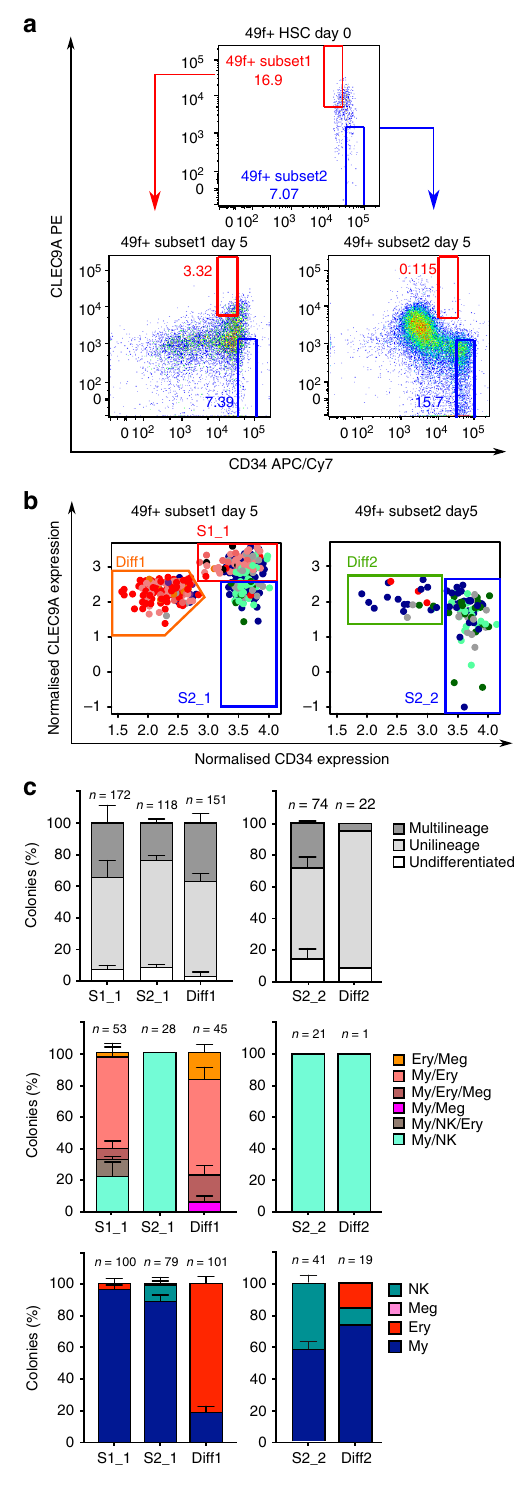
small grafts that were either My or My/Ery, while Subset2 cells generated either Ly, My or My/Ly grafts (Fig. 5e), consistent with our results in vitro. At 8 weeks post-transplantation, Subset1 cells started producing Ly cells (Fig. 5f). Strikingly, at 20 weeks post- transplantation, 13 out of the 19 mice engrafted with Subset1 cells displayed multilineage (Ly/My/Ery) engraftment in the injected bone while none of the six mice transplanted with Subset2 cells did ( p = 0.0149 by Fisher test considering mice at all levels of NATURE COMMUNICATIONS| (2018) 9:4100 |DOI: